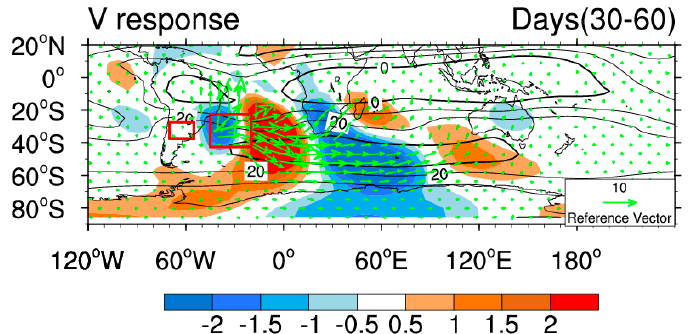
Figure 9. Response of rotational meridional winds (shading) and associated wave-activity flux (vector), averaged over the model day 30–60, in a linear barotropic vorticity equation model. The barotropic vorticity equation was linearized about the ERA-Interim reanalysis 200-hPa DJFM streamfunction climatology averaged over 1980–2016. Divergent forcing was applied over mid-latitude South America (27.5 ◦ –37.5 ◦ S, 55 ◦ –70 ◦ W) and the southwest South Atlantic (22.5 ◦ –42.5 ◦ N, 20 ◦ –45 ◦ W), depicted by the two boxes, with the divergence forcing of − 1 × 10 − 6 s − 1 and 1 × 10 − 6 s − 1 , respectively. Contour depicts climatological zonal winds at 200 hPa.